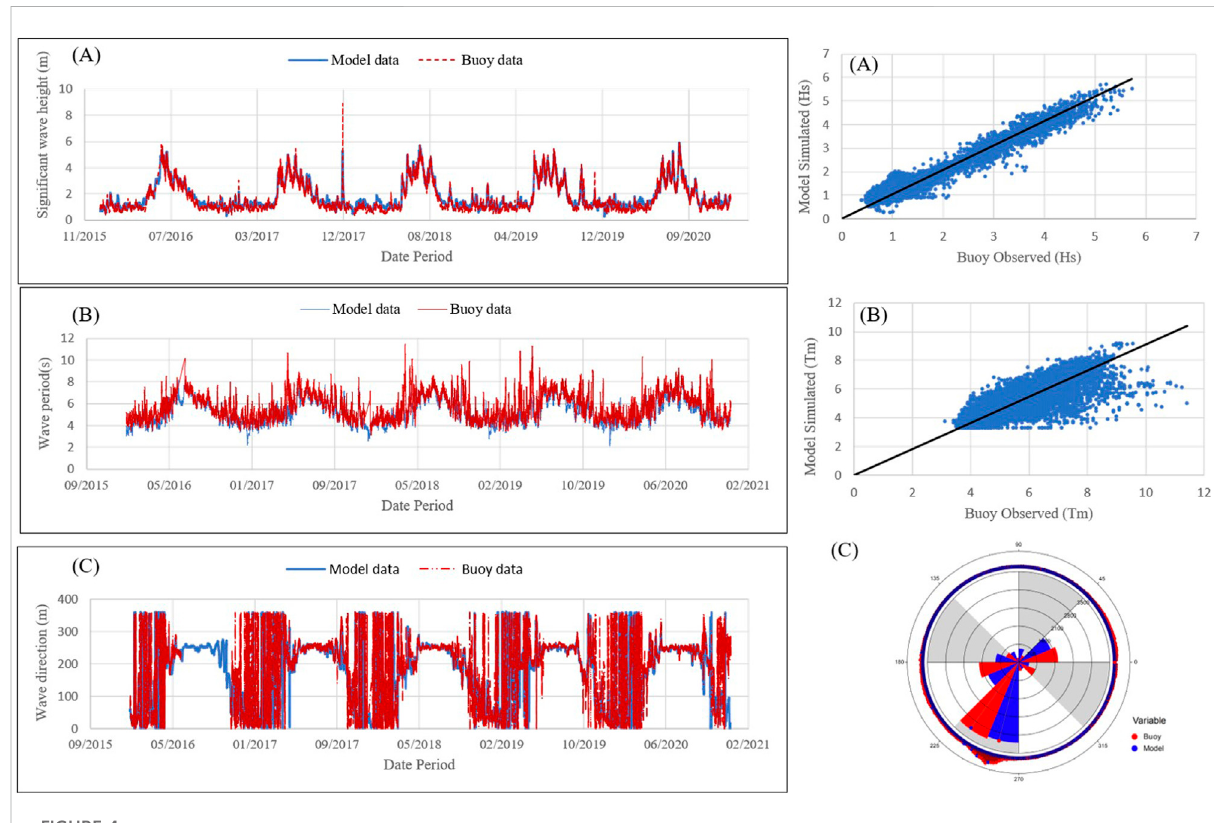
FIGURE 4 (left panel) Comparison of signi fi cant wave height between the modelled data and measured data at AD07 (A) Signi fi cant wave height (B) Mean wave period (C) Mean Wave direction; (right panel) Correlation between model simulated data and observed buoy AD07 data (A) Signi fi cant wave height (B) Mean Wave period (C) Mean Wave